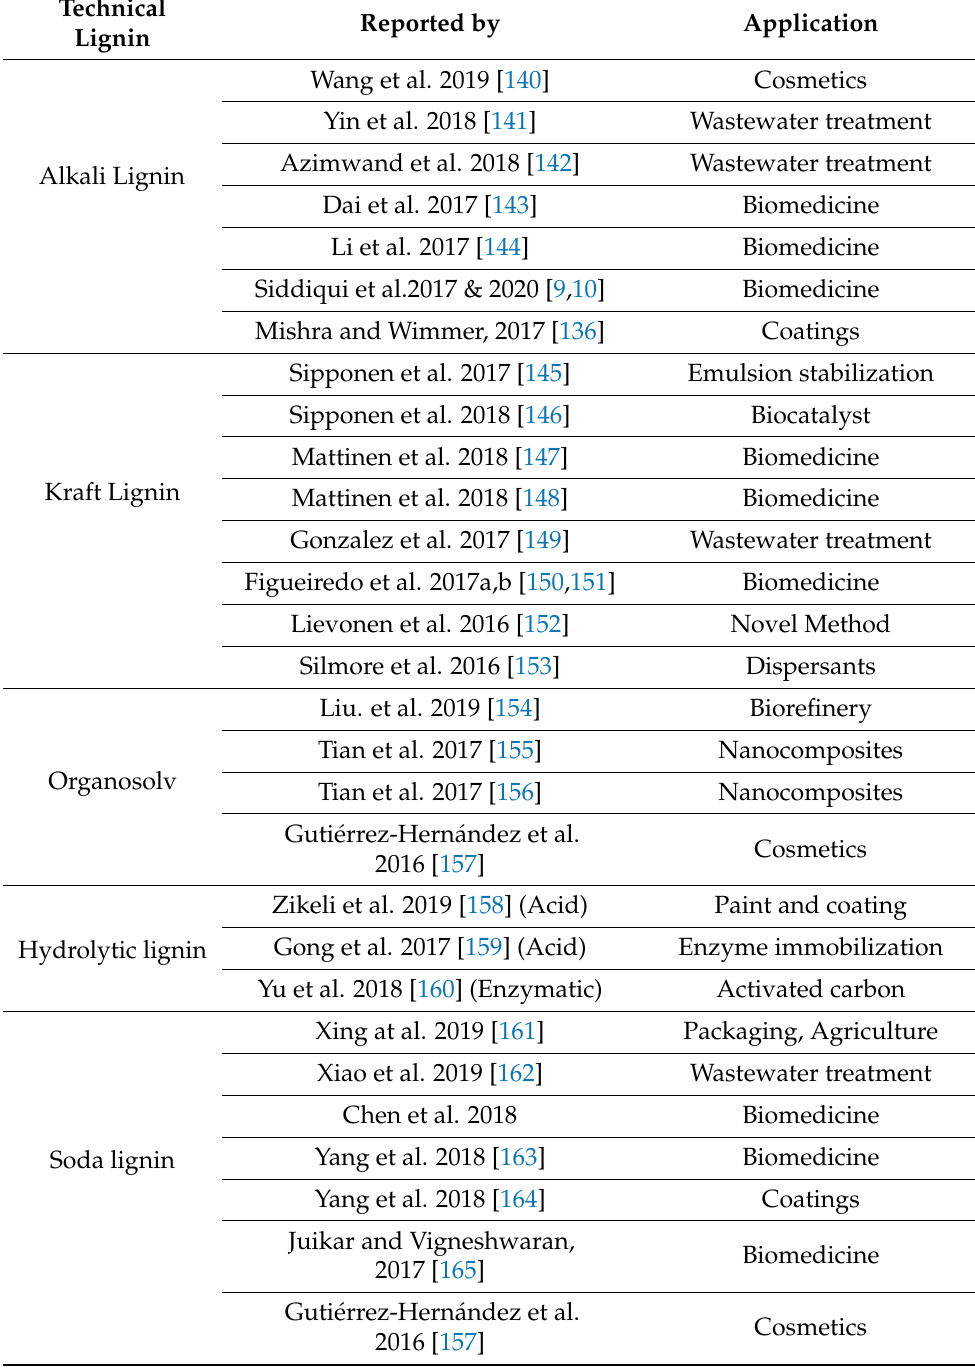
Table 4. Different technical lignin-based nanoparticles and their industrial